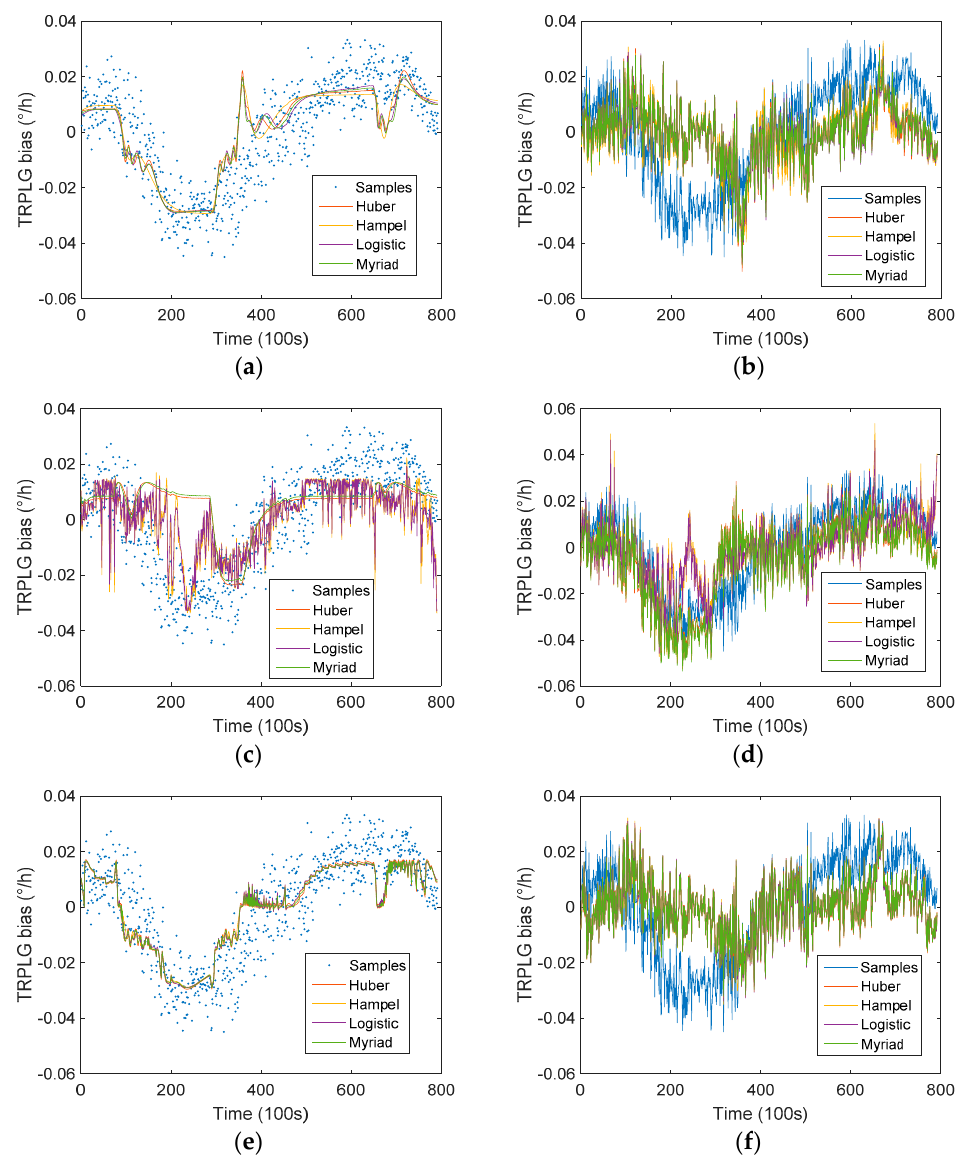
Figure 9. TRPLG bias compensation using different weight functions based on IR-LSSVM model: ( a )